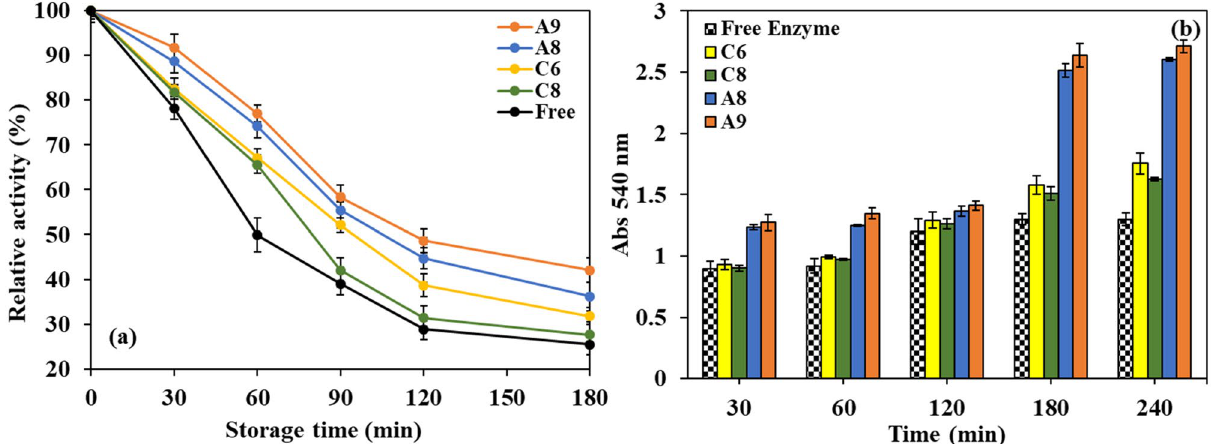
Figure 7. ( a ) Storage stabilities, and ( b ) comparative analysis of the reducing sugar release after treatment with the free PersiXyn9 and its immobilized forms on the selected hydrogel supports.